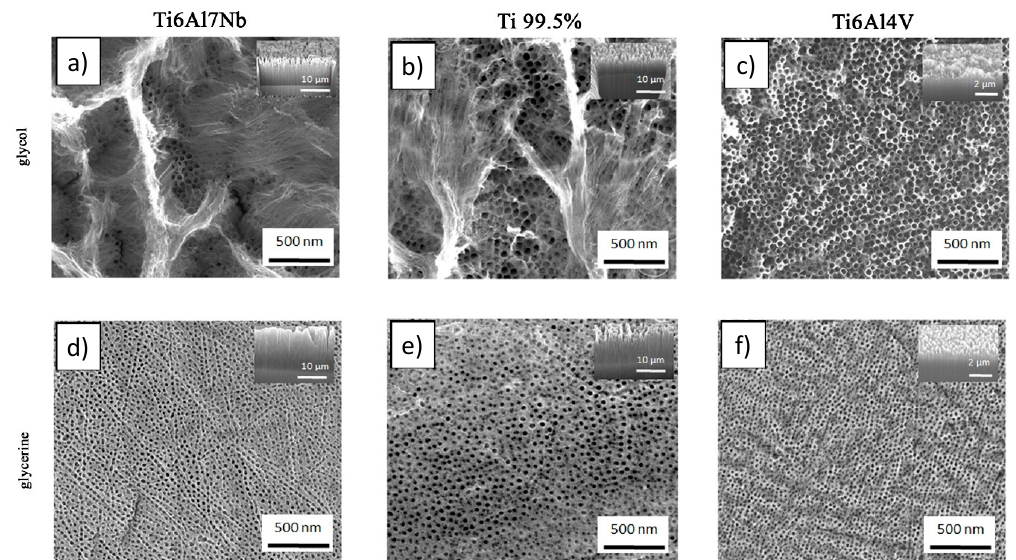
Figure 4. Top view and cross-section (insert) of anodic oxide layers on Ti6Al7Nb, Ti 99.5%, and Ti6Al4V alloys by anodization in glycol-based ( a – c ) and glycerol-based ( d – f ) electrolyte. In the top view, the scale bar corresponds to 500 nm for every substrate. In the cross-section, the scale bar represents 10 µm for Ti6Al7Nb and Ti 99.5%, and 2 µm for Ti6Al4V.